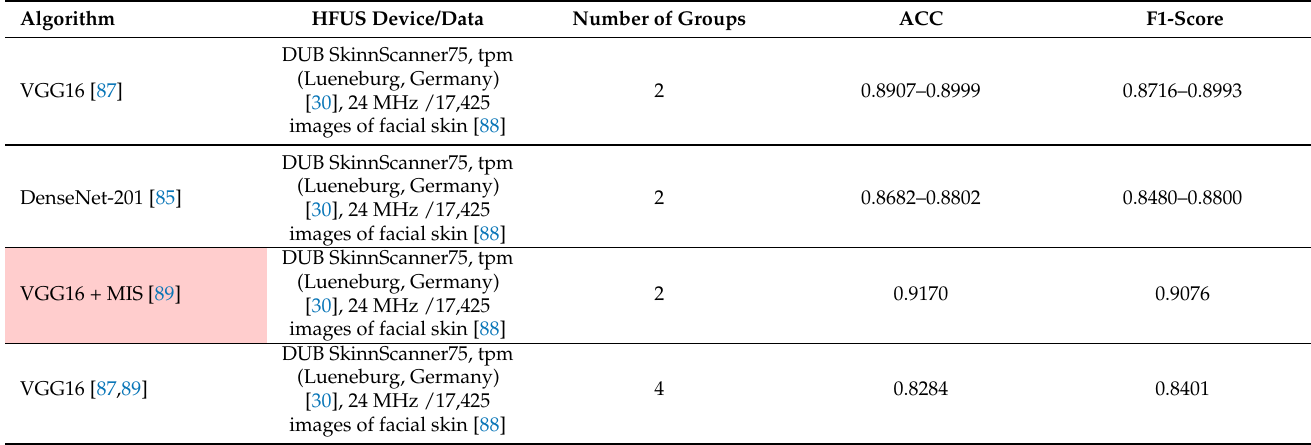
Table 10. IQA of HFUS images.